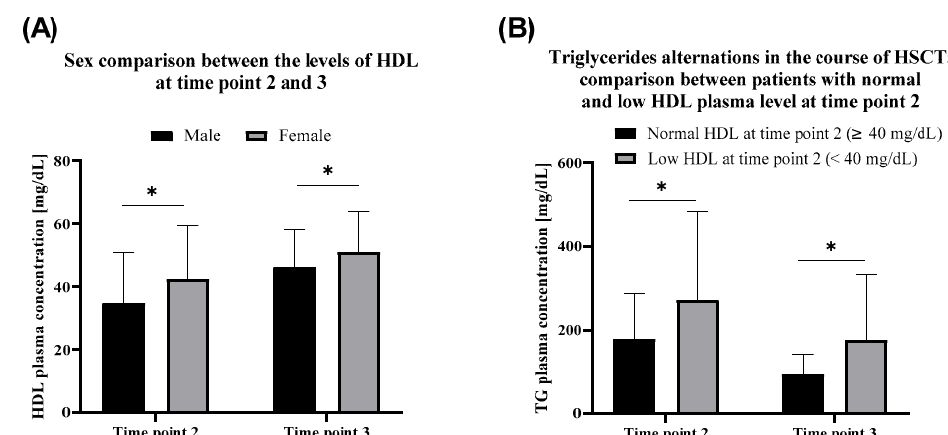
Figure 2. ( A ) Sex comparison between the levels of HDL(high-density lipoprotein) at time point 2 (date of the first appearance of disorder after HSCT) and time point 3 (last follow up visit). ( B ) Triglycerides alternations in the course of HSCT; the comparison between patients with normal and low HDL plasma level at time point 2. *, p < 0.01 (U-Mann-Whitney test). Groups with normal and low HDL levels at time point 2 showed no difference in the incidence of TG level disorder before HSCT ( p > 0.2 at time point 1). Furthermore, since HSCT until time point 3, the average triglycerides level decreased about twofold. The difference between the analyzed groups was observed (TG p = 0.000078 at time point 2 and p = 0.000044 at time point 3). Namely, during the therapy, TG raised higher in patients with low HDL at time point 2. During the treatment, the level of TG decreased ( p = 0.000003 for the group with normal HDL at time point 2 and p = 0.000409 for the group with low HDL at time point 2) in both groups, although remaining higher in the group with low HDL at time point 2 (Figure 2B). Patients with currently (time point 3) elevated triglycerides exhibited lower HDL at time point 2 as well as at time point 3 than the patients with normal TG levels (Figure 3A). Patients with currently normal TG level exhibited higher HDL serum concentration at time point 2 comparing to the group with currently high TG level. During the observation period, HDL levels tended to increase among both patients with currently high ( p = 0.000002) and normal ( p = 0.000086) TG levels.